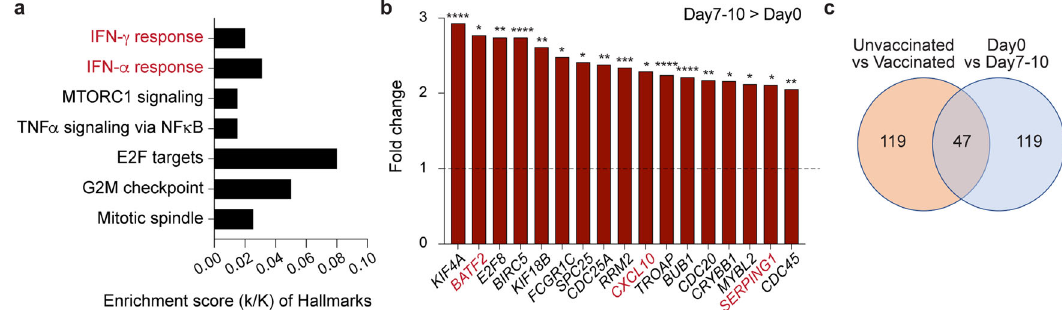
Fig. 5 Immune transcriptome induced upon BNT162b2 vaccination. a Genes expressed at signi fi cantly higher levels at Day 7 – 10 from the vaccination were signi fi cantly enriched in Hallmark Gene Sets (FDR q value < 0.005). b Relative mRNA levels of 17 genes that are induced at Day 7 – 10 as compared to Day 0 and enriched in IFN signaling are presented by bar graphs. A p value by the Wald statistic from DESeq2 were listed in Supplementary Data 5. * p < 0.05, *** p < 0.0001, **** p < 0.00001. c Transcriptional signatures in vaccinated naïve individuals and vaccinated COVID-19 patients. The Venn diagram displays the number of signi fi cantly induced